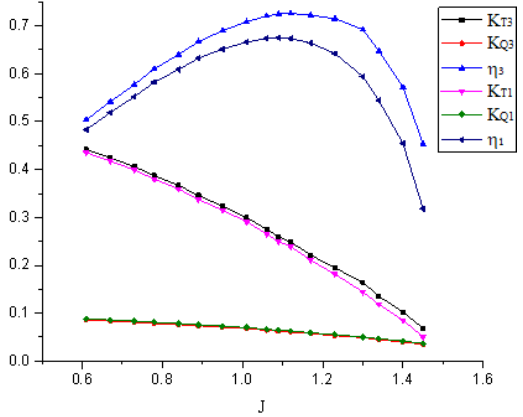
Figure 25. Comparison curves of pump-jet performance before and after optimization.